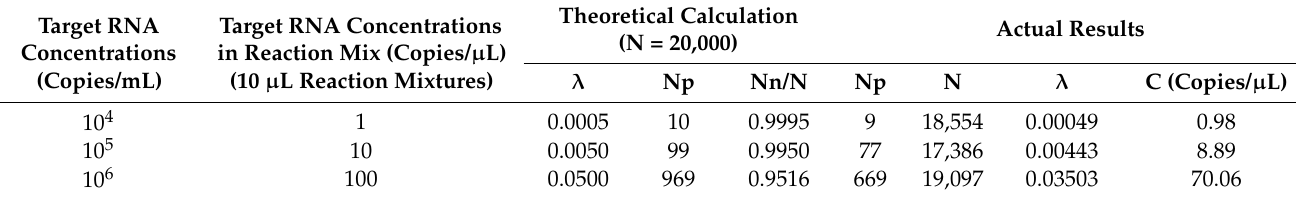
Table 1. The accuracy and sensitivity of a bioluminescent signal-based digital LAMP assay. Target RNA